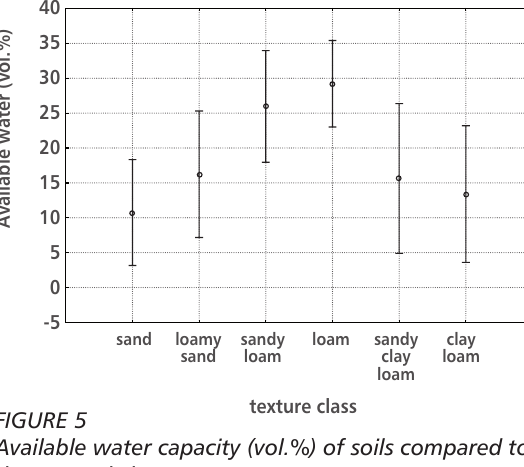
Available water capacity (vol.%) of soils compared to the textural